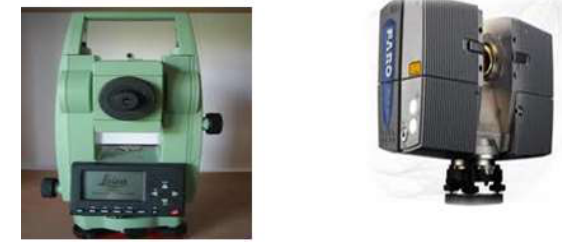
Figure 2. Leica 307 TCR (left) and Faro Photon 120/20 (right). The rangefinder is used to survey all corners of a room and via